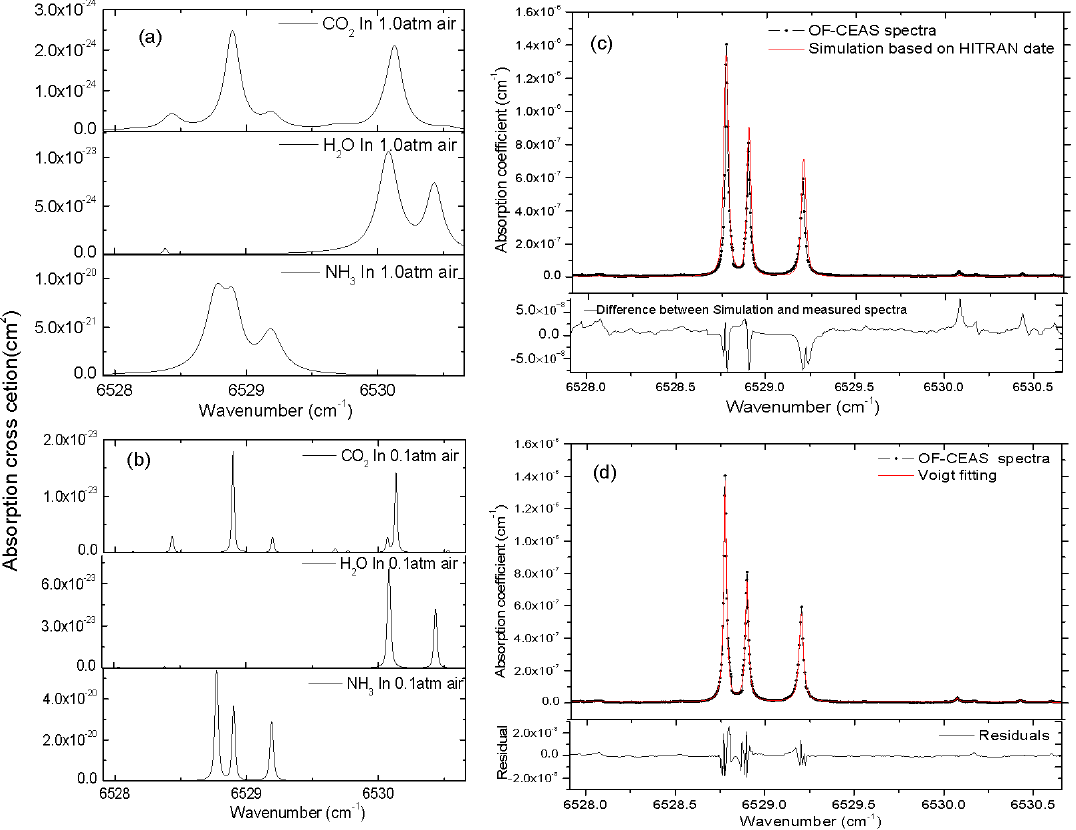
Figure 3. ( a , b ) represent the cross-section of NH 3 , H 2 O and CO 2 at the temperature of 296 K and a total pressure of 1.0 atm and 0.1 atm, respectively. Measured absorption coe ffi cient spectra of 10 ppm of NH 3 in N 2 at a total pressure of 0.1 atm (shown in black dot) together with absorption coe ffi cient spectra computed from HITRAN 2012 data (shown as red line) are presented in ( c ). The fitting of the absorption spectra by the Voigt profile is also shown in ( d ), the standard deviation of the residuals gives a minimum absorption coe ffi cient of α min = 1.6 × 10 − 9 cm − 1 in a single scan within 5 s.